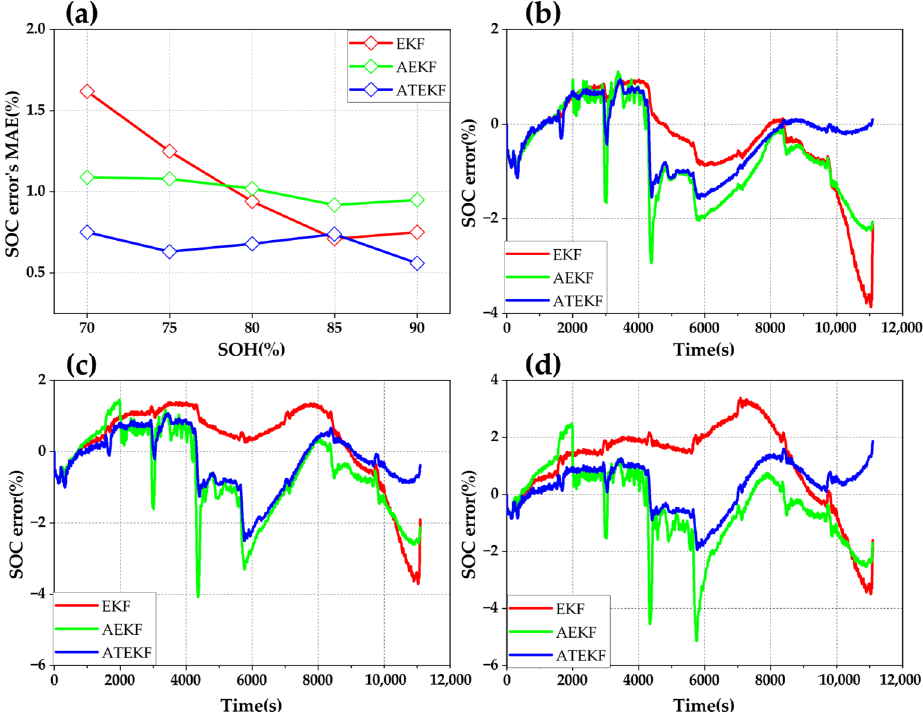
Figure 14. SOC error of three algorithms under different SOH: ( a ) MAEs of EKF, AEKF, and ATEKF under different SOH; ( b ) SOC error comparison of EKF, AEKF, and ATEKF with SOH = 90%; ( c ) SOC error comparison of EKF, AEKF, and ATEKF with SOH = 80%; ( d ) SOC error comparison of EKF, AEKF, and ATEKF with SOH = 70%.